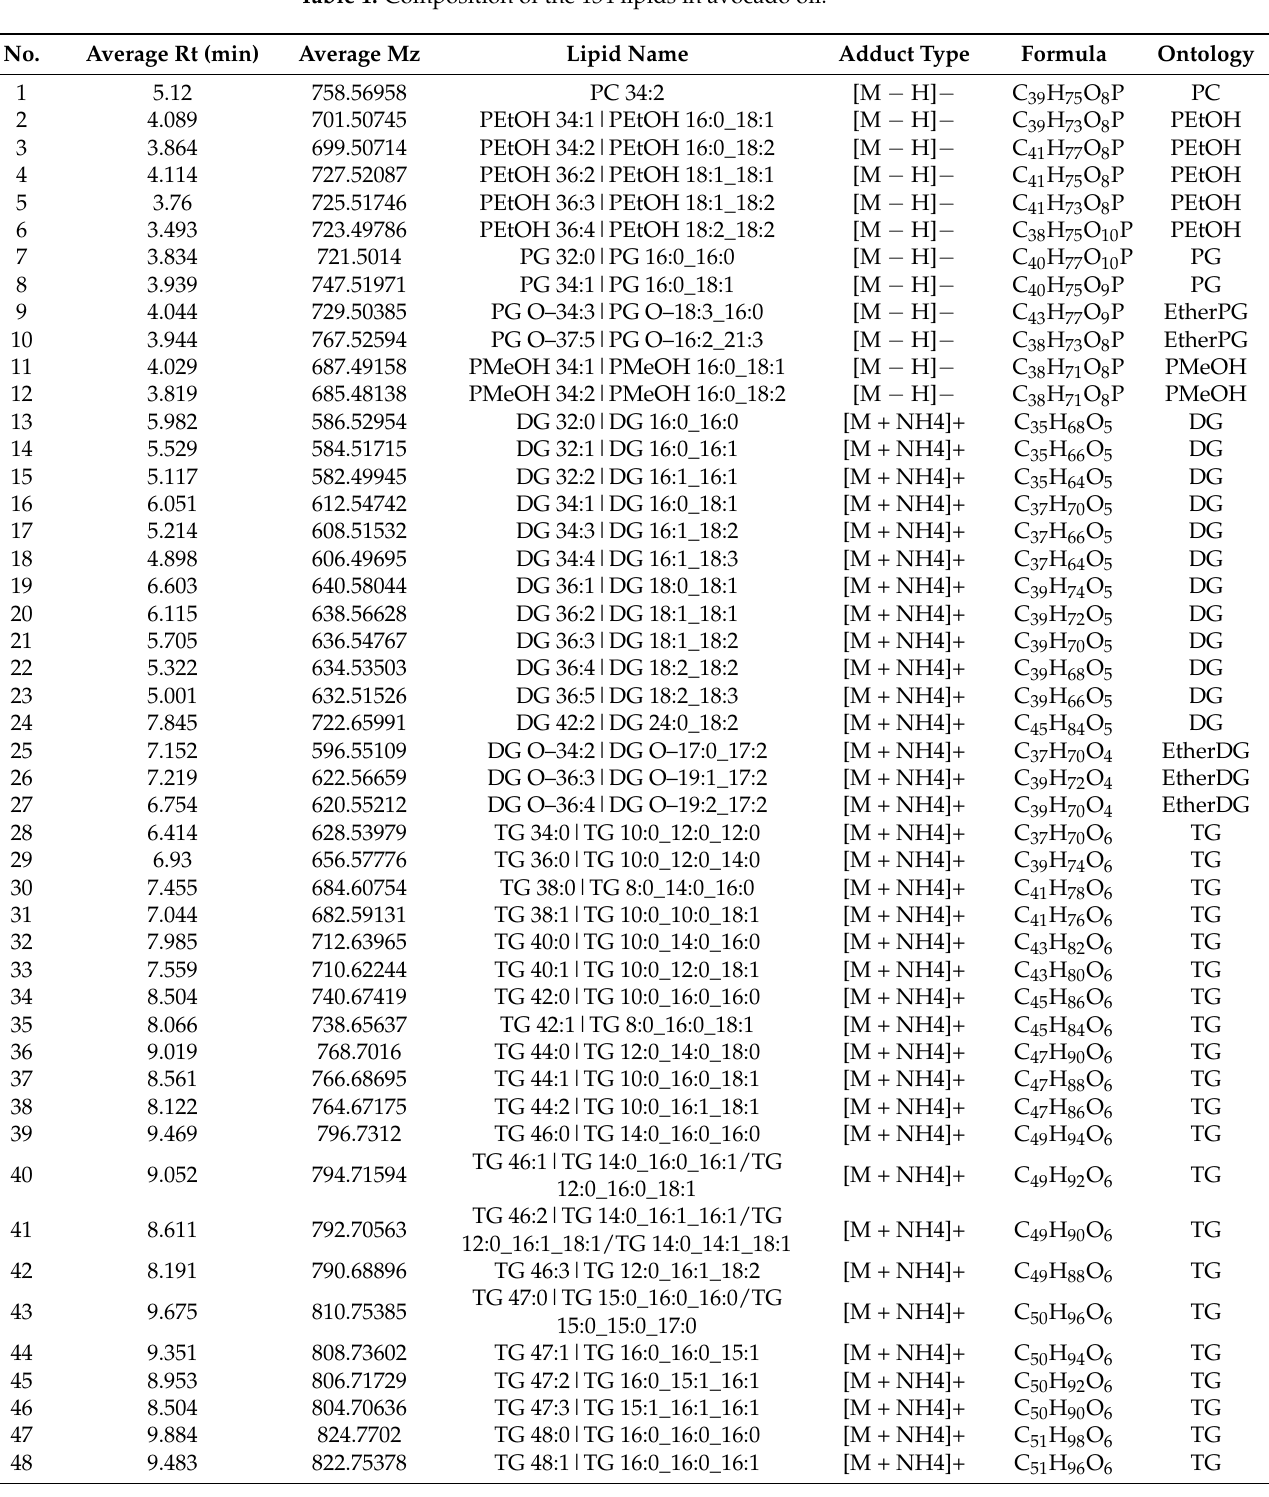
Table 1. Composition of the 134 lipids in avocado